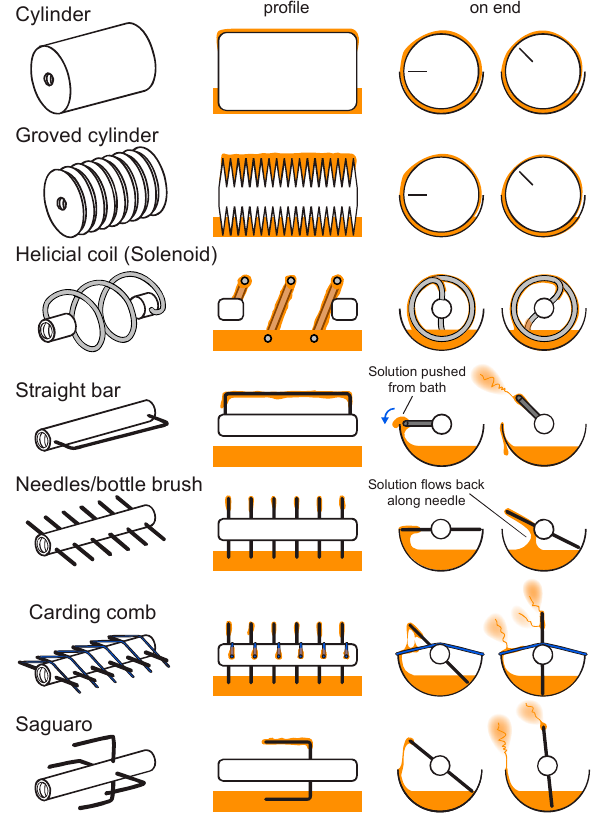
Figure 6. Electrode designs characterized by viscous solutions. The bottom designs were the most successful for spinning viscous solutions. Each design is discussed further in the text.